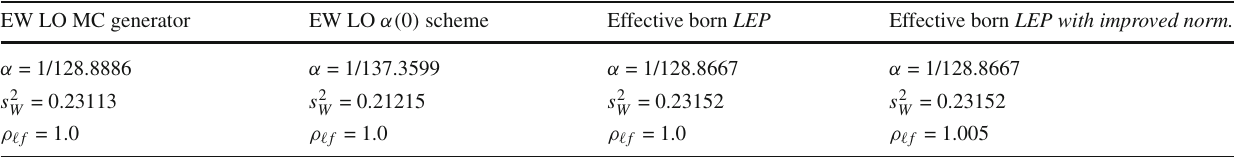
Table 2 The EW parameters used for: (i) MC events generation, (ii) case parameters are chosen such that the SM relation, formula (18), is the EW LO α( 0 ) scheme, (iii) effective Born spin amplitude around the obeyed. The G μ = 1 . 166389 · 10 − 5 GeV − 2 , M Z = 91.1876 GeV and , K , K (cid:2) K Z -pole and (iv) effective Born with improved normalization. In each f e f = 1 are taken EW LO MC generator EW LO α( 0 ) scheme Effective born LEP Effective born LEP with improved norm. α = 1/128.8886 α = 1/137.3599 α = 1/128.8667 α = 1/128.8667 s 2 = 0.23113 s 2 = 0.21215 s 2 = W W W